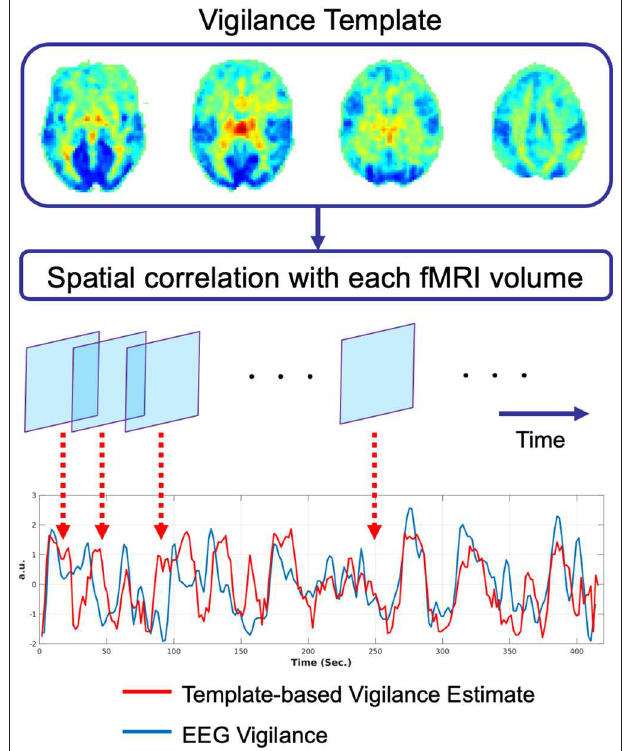
FIGURE 2 | Graphical summary of the template-based approach for prediction of vigilance fluctuations as described in Chang et al. (2016). The vigilance template is obtained by correlating the fMRI data with an estimate of EEG vigilance measure as described in Falahpour et al. (2018a), using data originally acquired for a prior study ( Wong et al., 2013). This vigilance template was then applied to an independent simultaneous EEG-fMRI dataset. For each timepoint in the fMRI data, the spatial correlation between the template and the fMRI volume is computed to form an estimate of vigilance (red line). This estimate is highly correlated ( r = 0.51) with the EEG-based measure of vigilance (blue line).